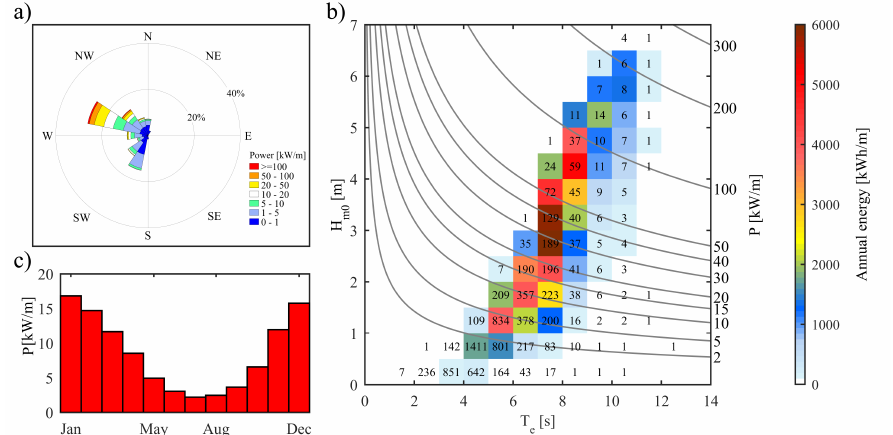
e T e , the colour scale indicates annual 0